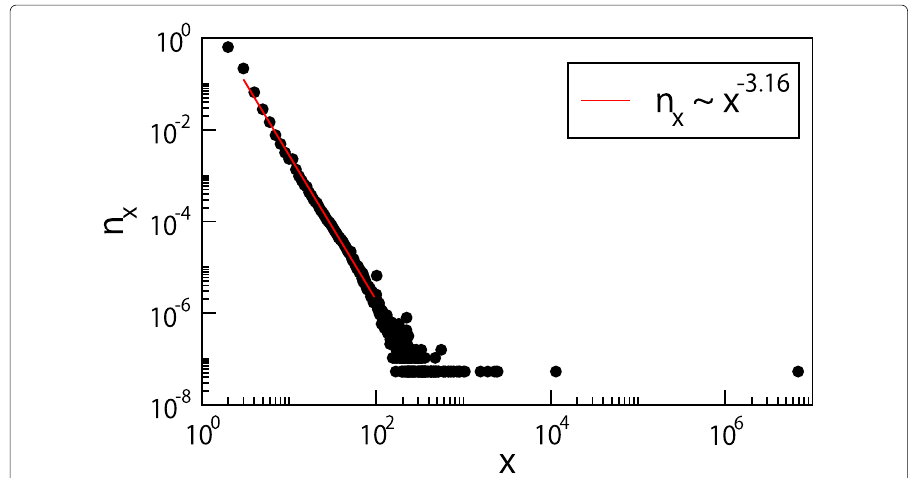
Fig. 8 Distribution n x of the component sizes x in the network. The red line indicates the best power law fit to the